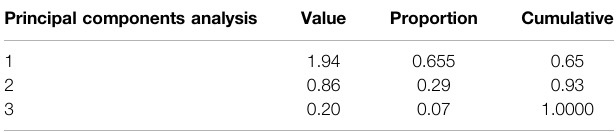
TABLE A1 | Export costs index (based on the three measures of export